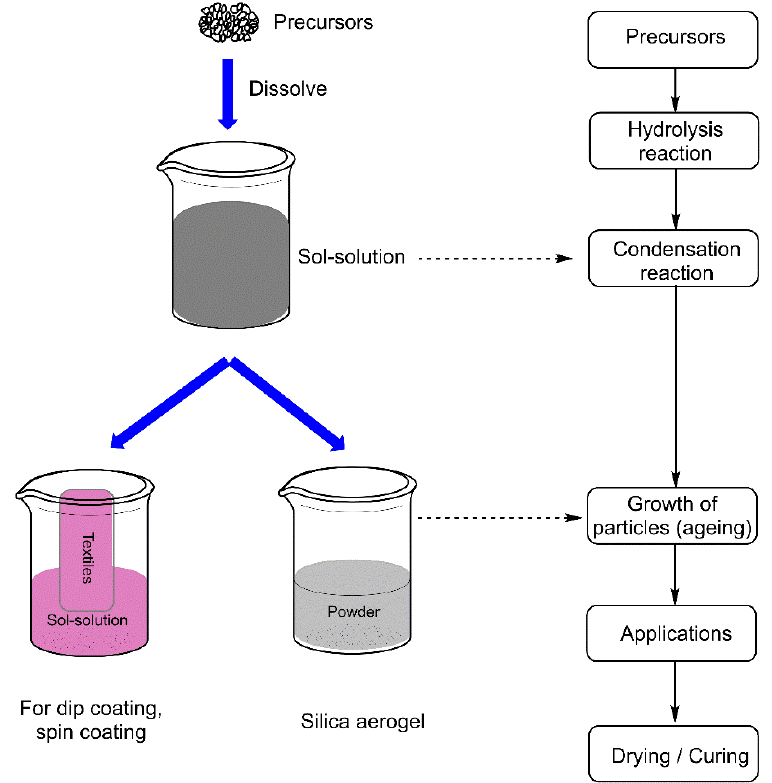
Figure 2. Steps involved in a sol-gel process.